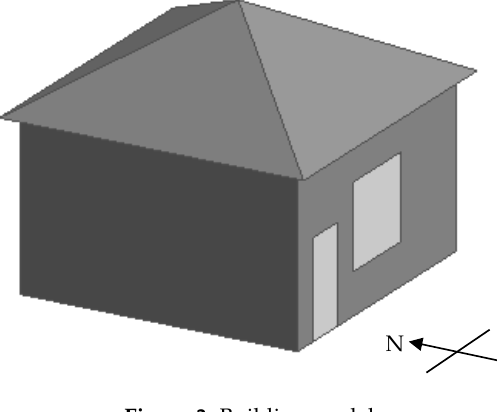
Figure 3. Building model.